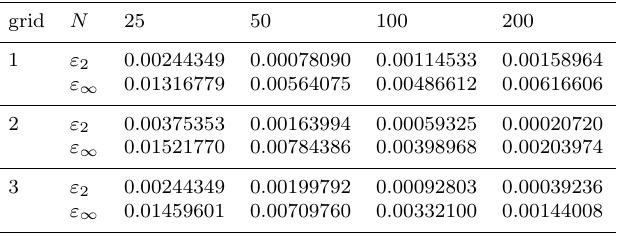
Table 2. Error of the solution for the regularized scheme (4.2), (4.6) ( µ = 10) grid